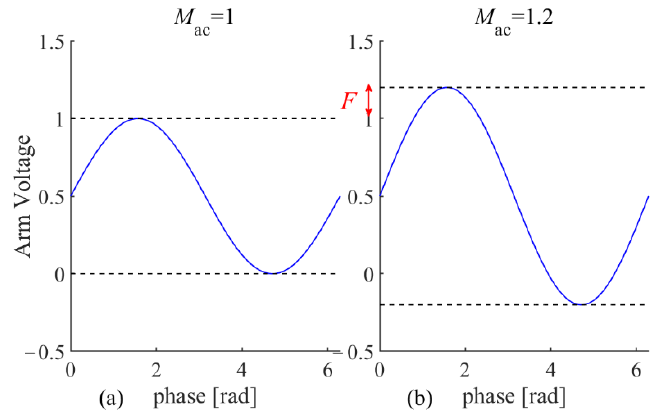
Figure 3. Relation between the number of FBSMs and the arm voltage: ( a ) HB-MMC; ( b ) hybrid MMC.